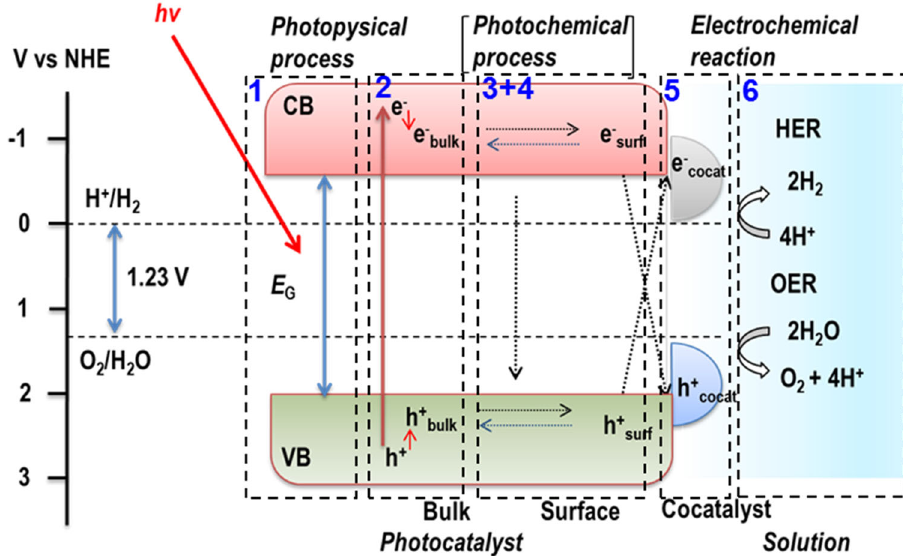
Fig. 1 Schematic of processes involved in photocatalytic water splitting. The steps involved in the photocatalysis for water splitting process are presented in the scheme: 1 photon absorption, 2 exciton